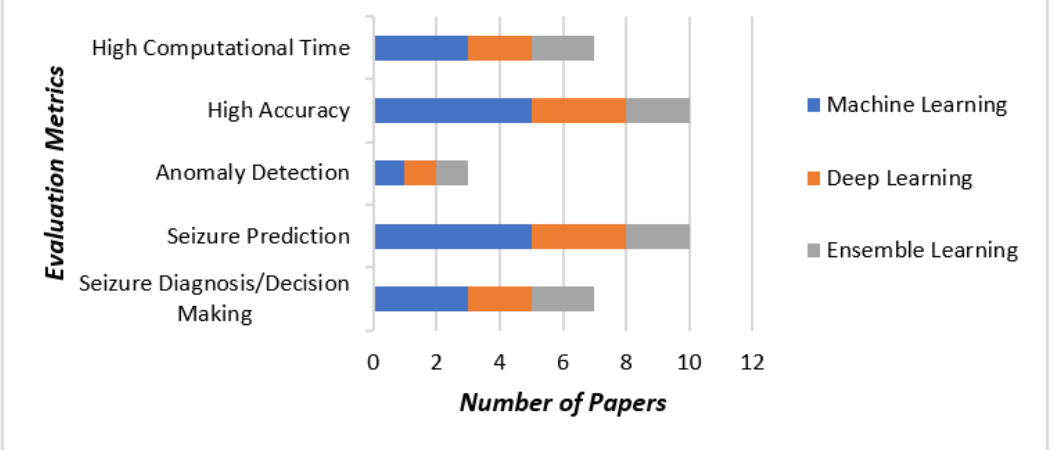
Figure 1. Outline of the distribution of three methods concerning evaluation metrics considered in this review.